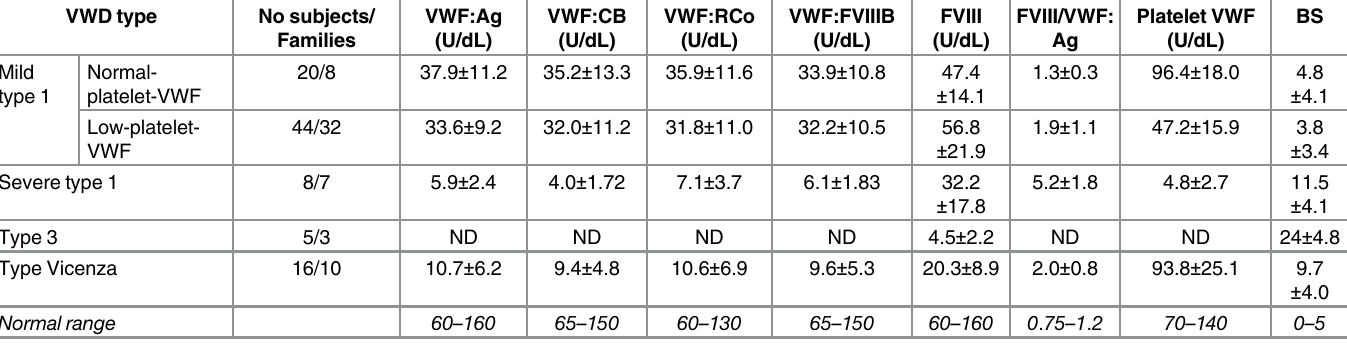
Table 1. Main haemostatic findings of the VWD patients with quantitative VWF defects